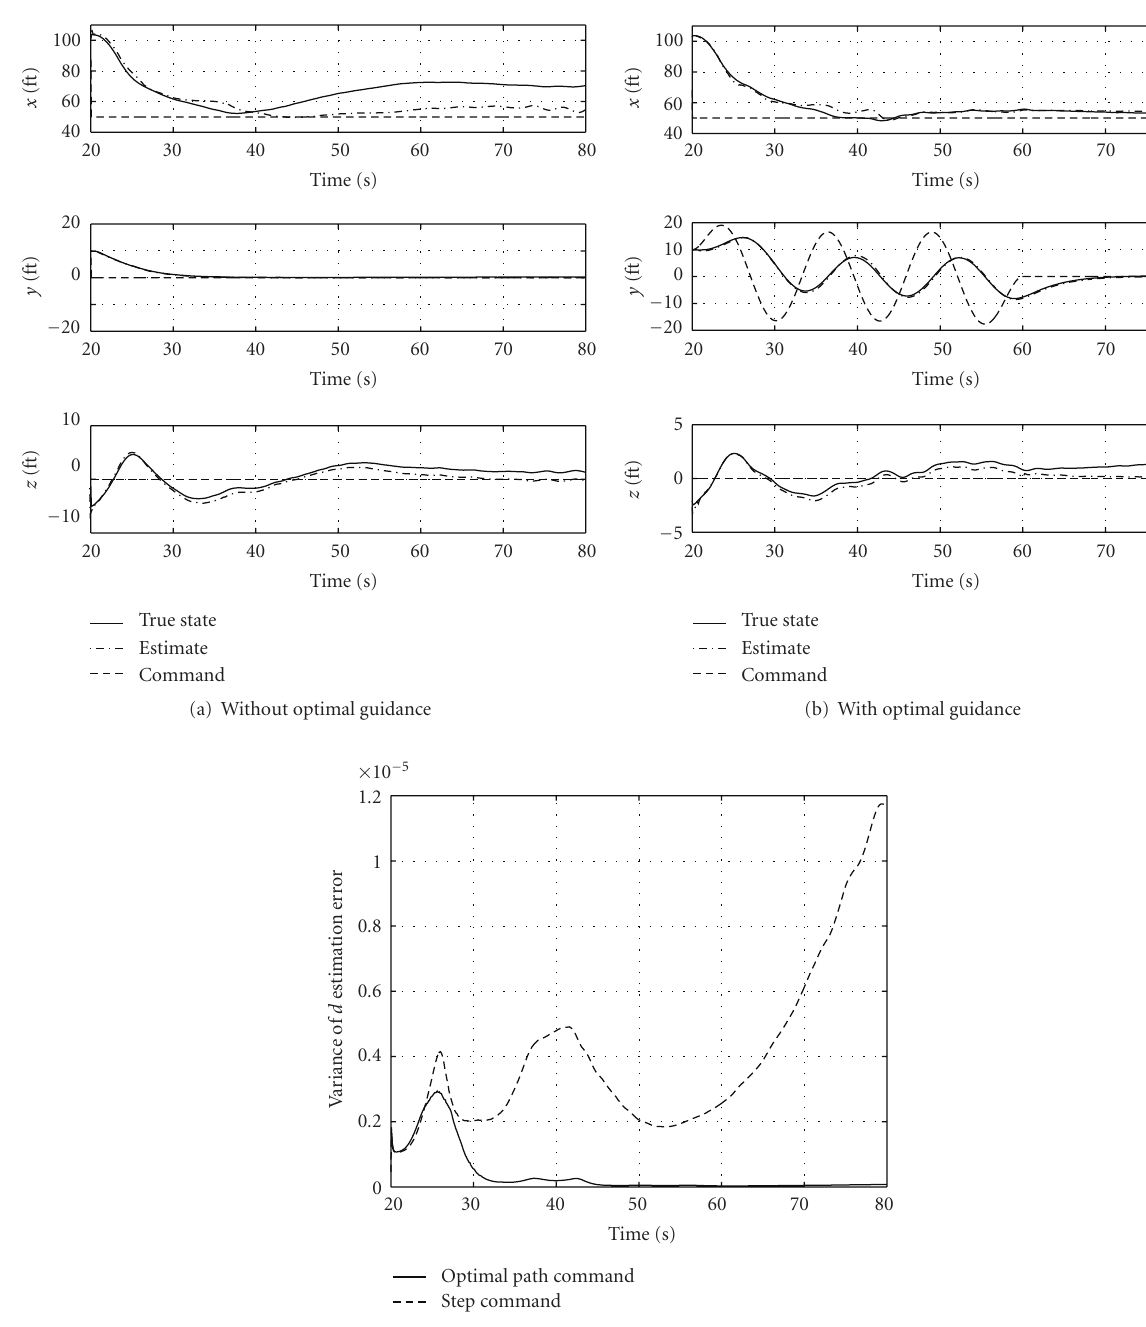
Figure 8: Optimal trajectory for range